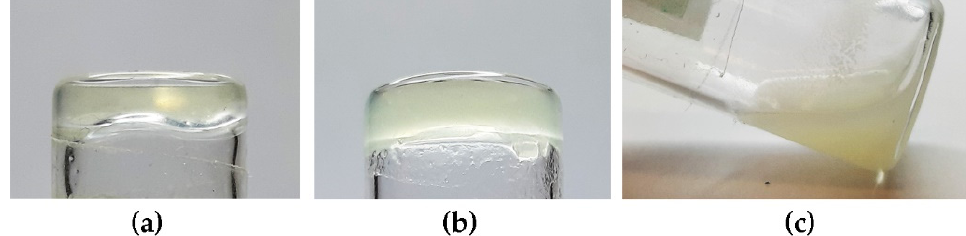
Figure 4 . Crystal packing of ( a ) DKP2 (CCDC 2209459) and ( b ) DKP4 (CCDC 2209458) as viewed along the a and b axis, respectively. The independent molecules in the asymmetric unit are depicted in green, blue, red, and yellow in DKP2 and green and blue in DKP4.